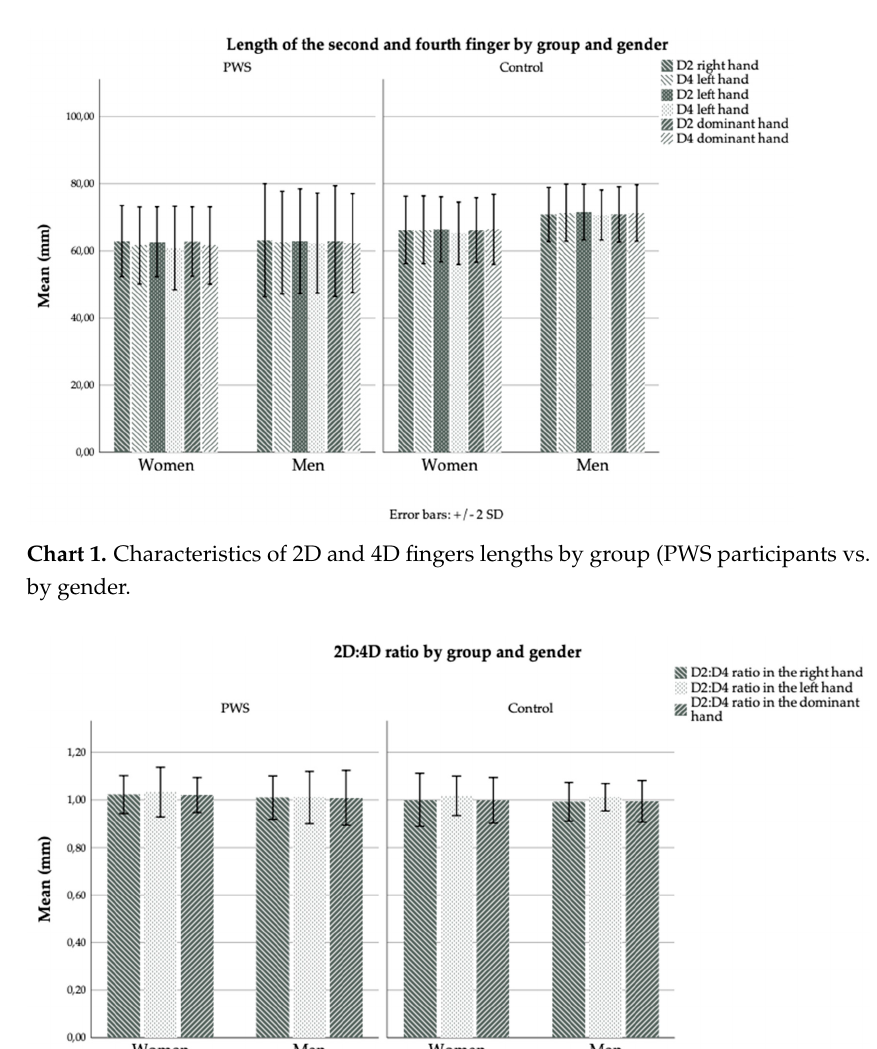
annular. 2D:4D = second finger/fourth finger ratio. R hand = Right hand. L hand = Left hand. D hand: dominant hand. Bold is for significant relationship.